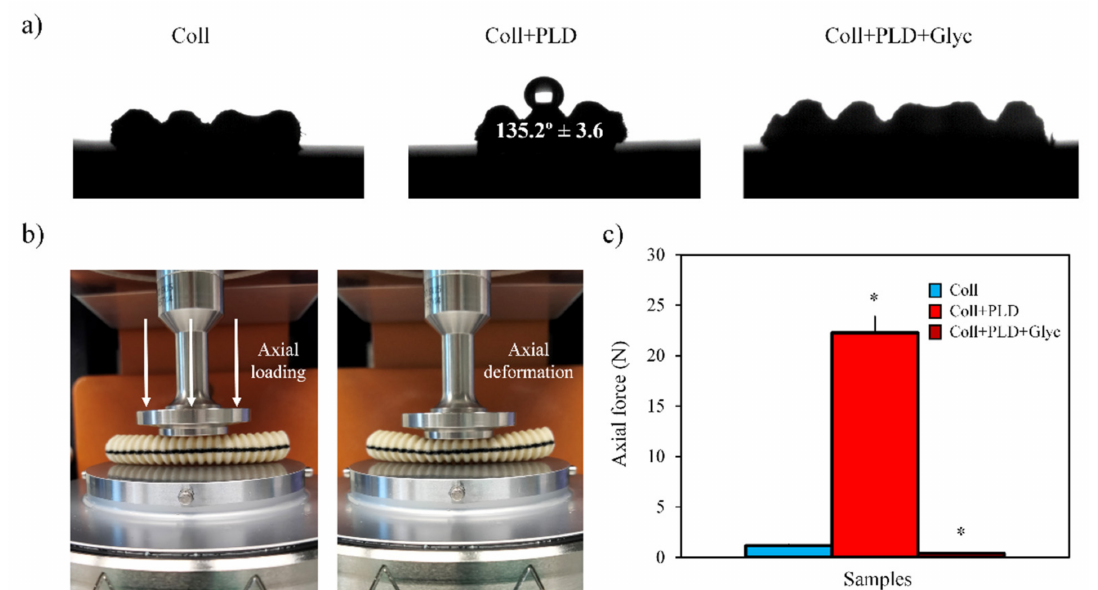
Figure 2. ( a ) Contact angle profile images of the Coll, Coll+PLD and Coll+PLD+Glyc vascular grafts. ( b ) Coll vascular graft placed between the parallel plates of the rheometer before and after applying axial loading force to deform the sample. ( c ) Axial force at 50% deformation for Coll, Coll+PLD and Coll+PLD+Glyc samples. (*) symbol indicates statistically significant differences for Coll+PLD and Coll+PLD+Glyc samples in comparison to the Coll